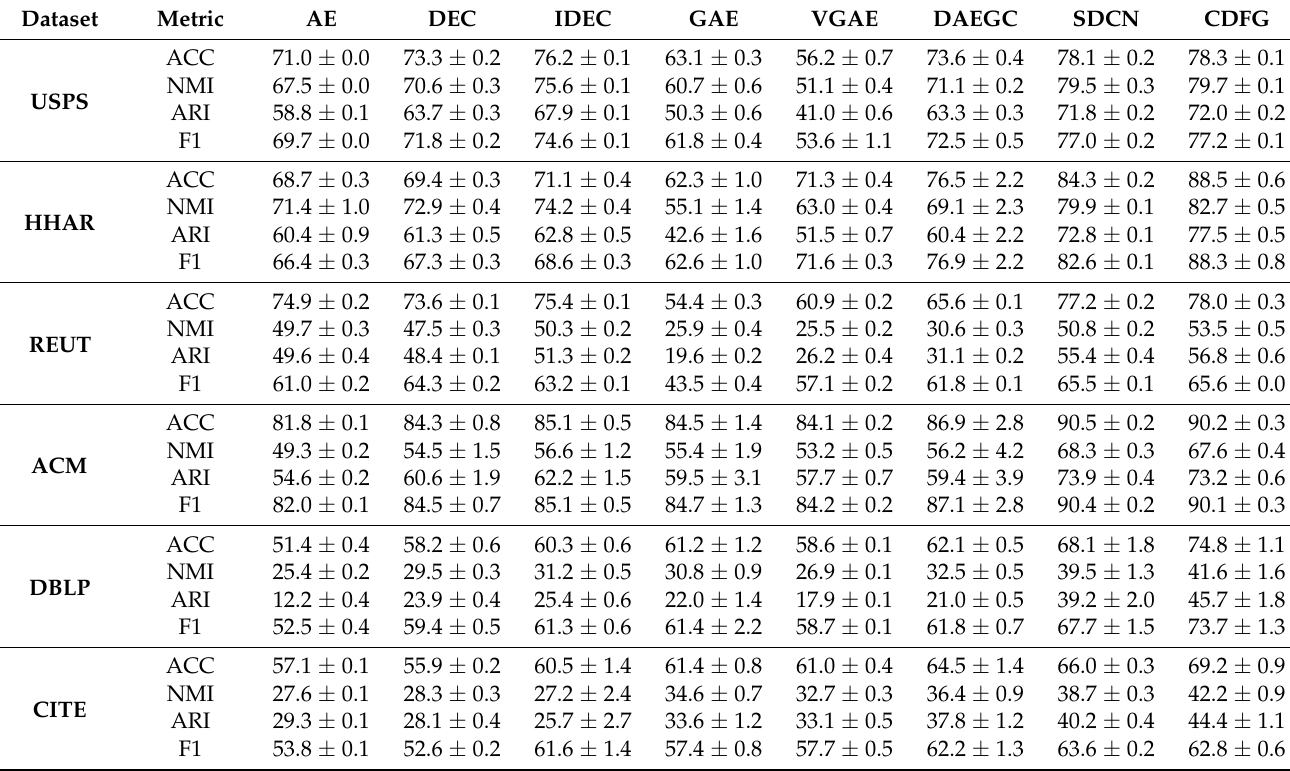
Table 2. Clustering results on six datasets (mean ±